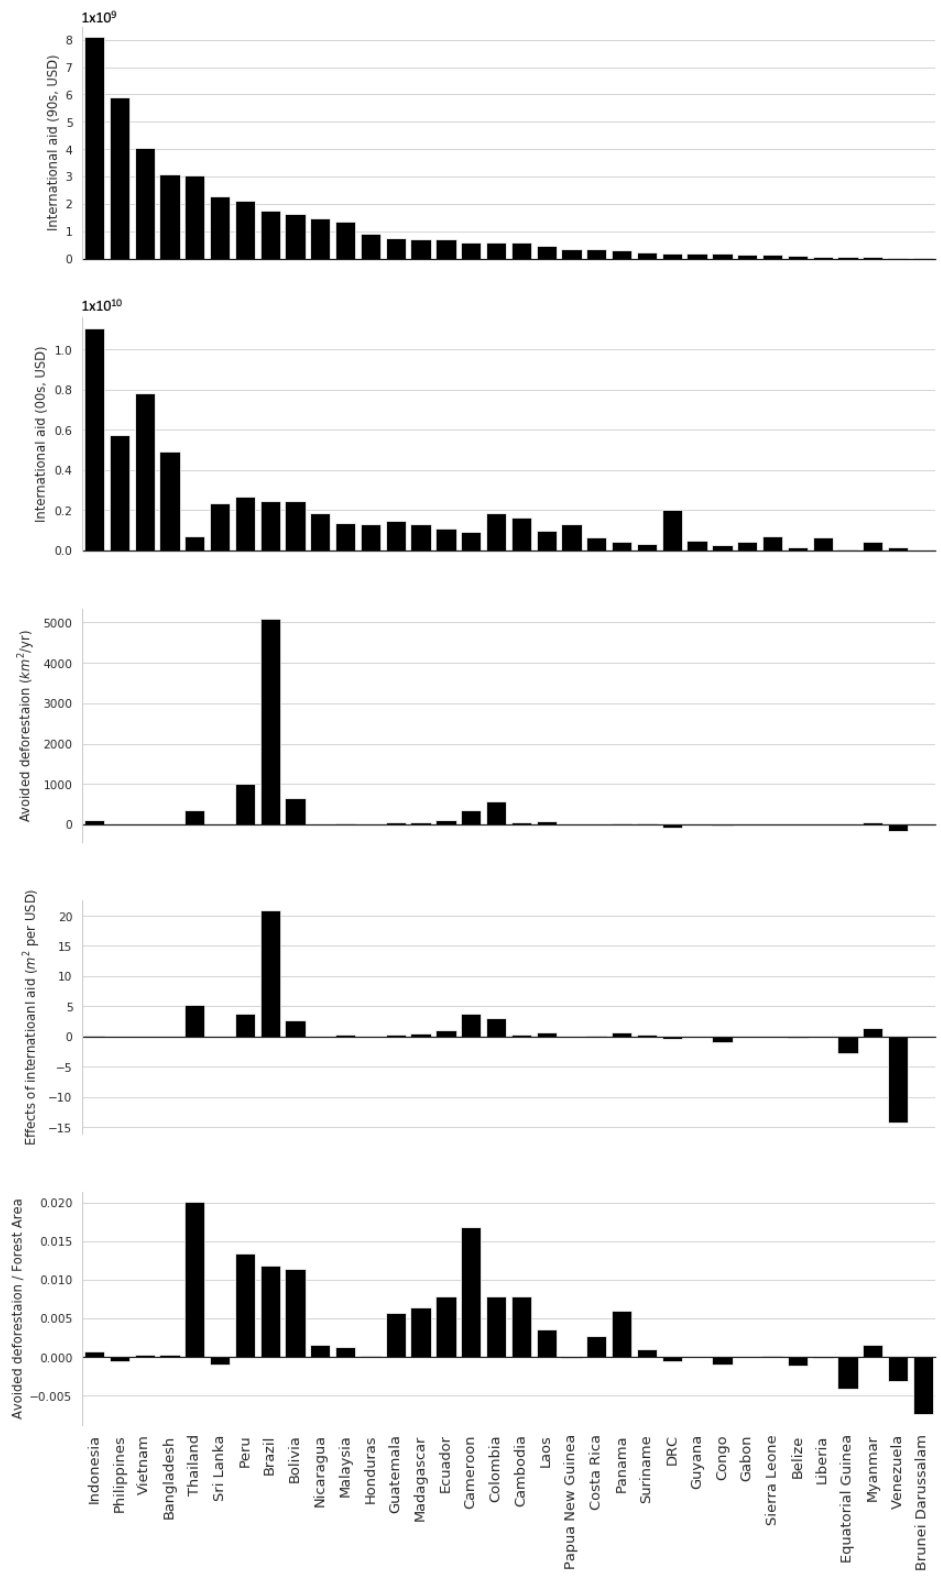
Figure 3. The amount of international funds committed to each tropical country in the 1990s and the 2000s; the amount of funds are converted to a nominal value of USD; avoided deforestation by each country; effects of international aid (amount of international aid per unit of avoided deforestation) for 34 tropical countries; and avoided deforestation divided by the entire forest area of each country.